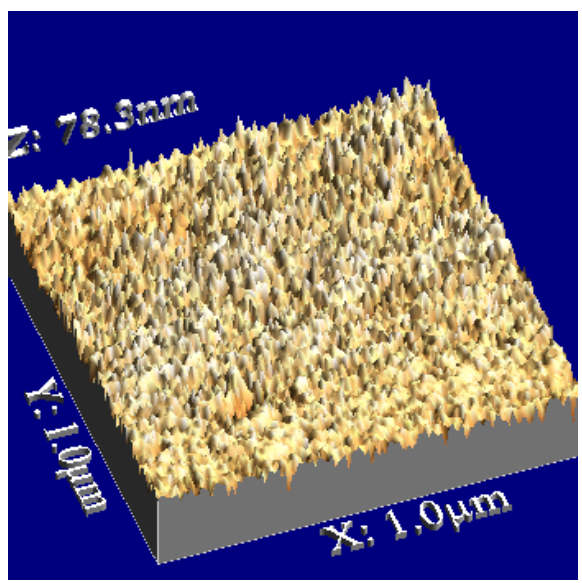
Fig. 7 AFM images of silica (TMOS) hybrids containing 15 mol % calcium alginate.